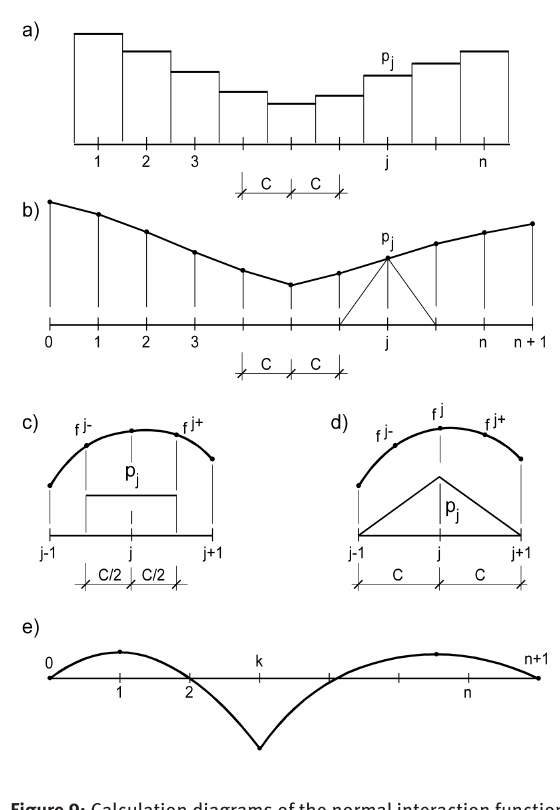
Figure 9: Calculation diagrams of the normal interaction